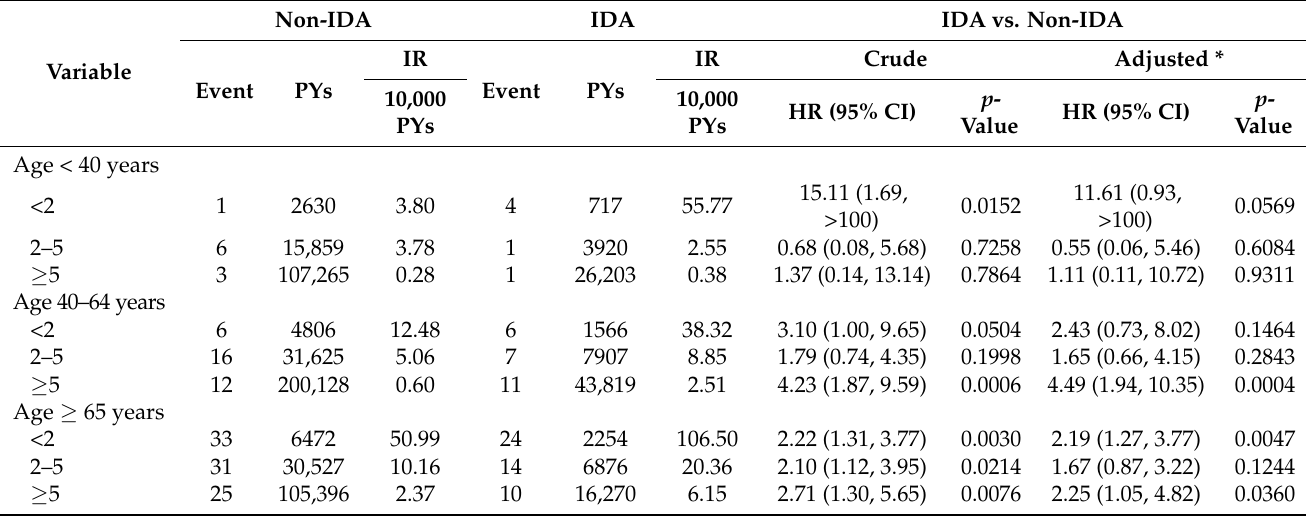
Table 4. The incidence of septic arthritis stratified by age and follow-up periods.